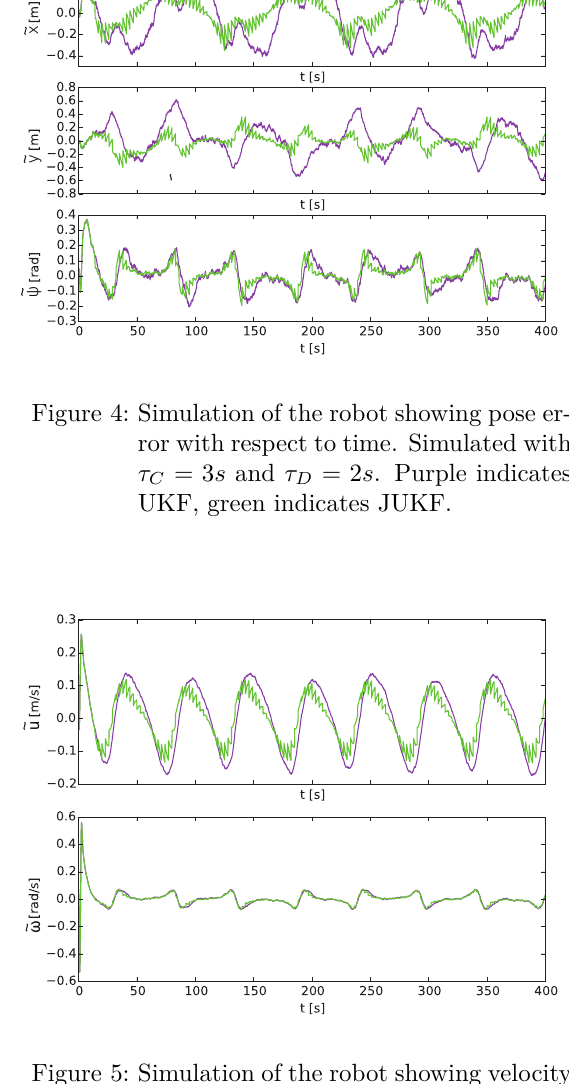
Figure 5: Simulation of the robot showing velocity error with respect to time. Simulated with τ C = 3 s and τ D = 2 s . Purple indi- cates UKF, green indicates JUKF.